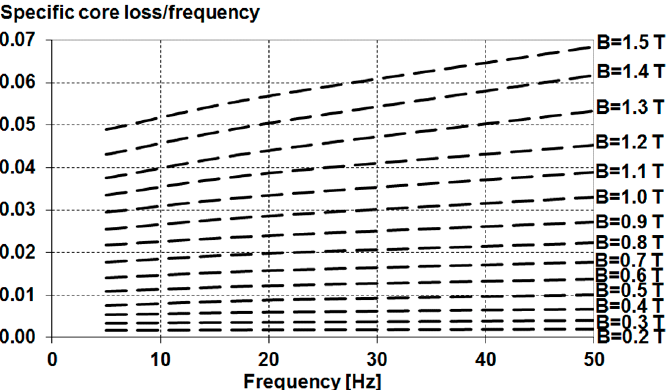
Figure 1. The quotient of specific core loss and frequency for the tested sheet metal strip 4 mm wide as a function of frequency for the frequency range from 5 Hz to 50 Hz for constant magnetic induction values from 0.2 T to 1.5 T.